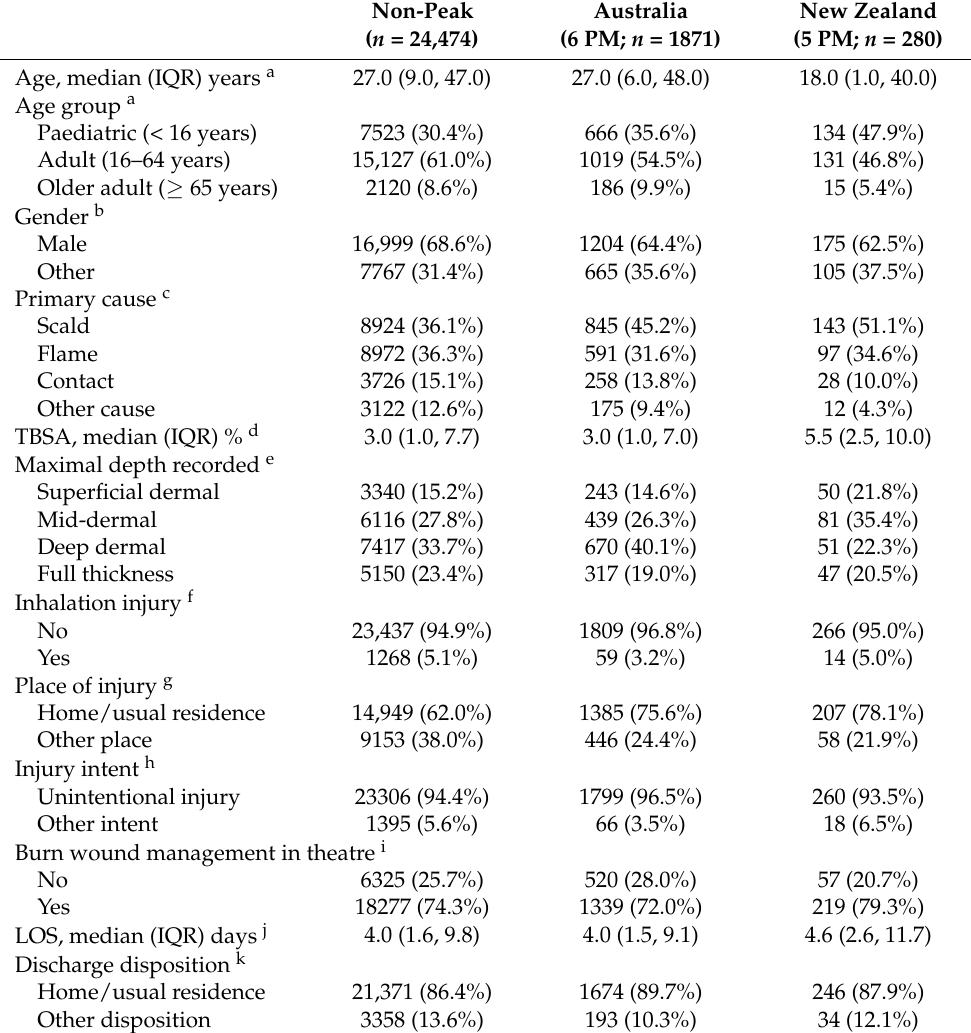
Table 2. Demographic and injury characteristics of patients injured in peak